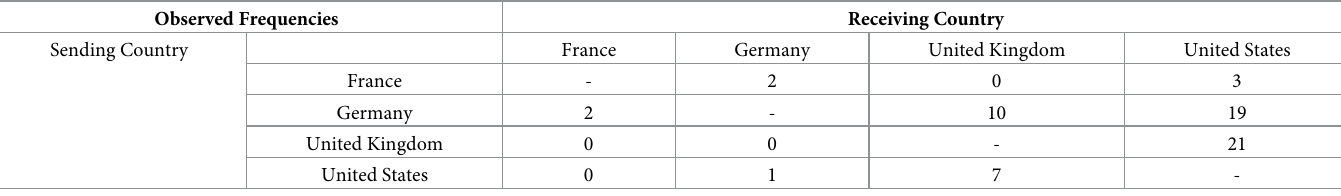
Observed frequencies of (future) laureate mobility for the entire observation period 1901–2017. Mobility includes moves from HD to PWR and/or from PWR to